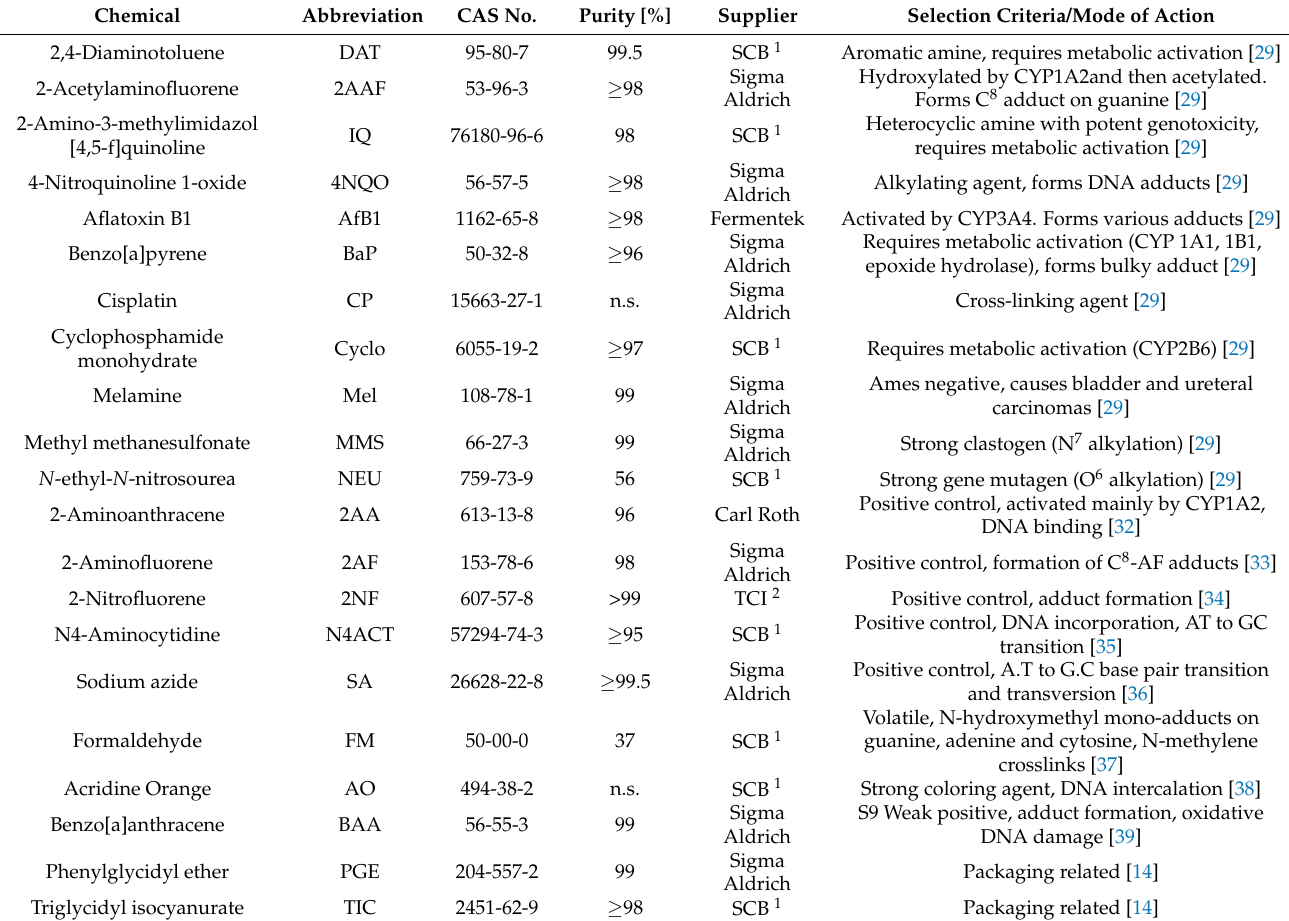
Table 1. List of test substances used for the direct LEC comparison as well as the S9